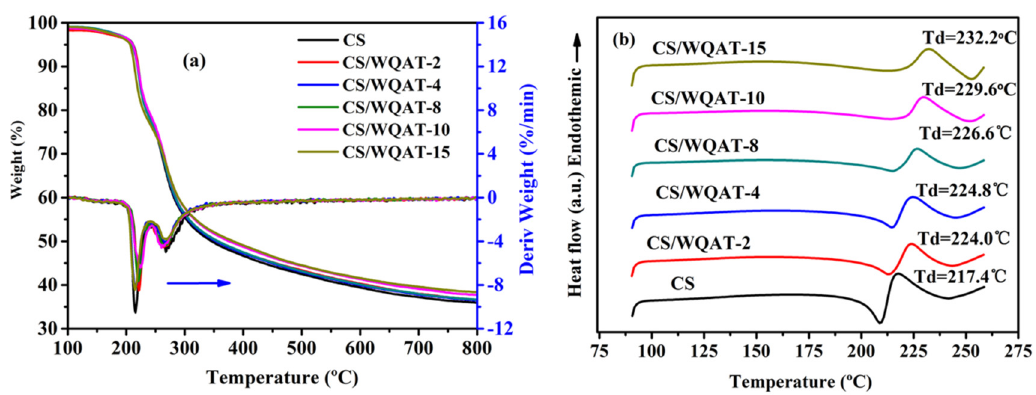
Figure 5. ( a ) TGA-DTG and ( b ) DSC curves of CS / WQAT composite membranes. Figure 5. ( a ) TGA ‐ DTG and ( b ) DSC curves of CS/WQAT composite membranes.